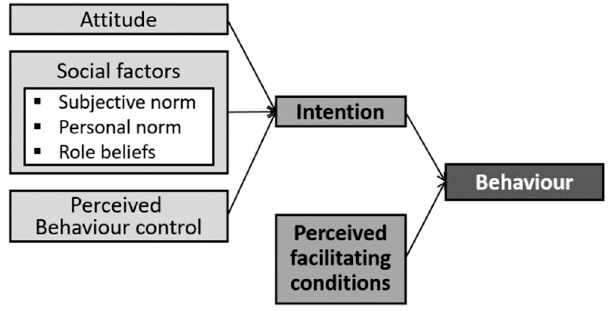
Figure 4. Combination model between Traindis’s theory of interpersonal behaviour (TIB) and Azjen’s theory of planned behaviour (TPB).